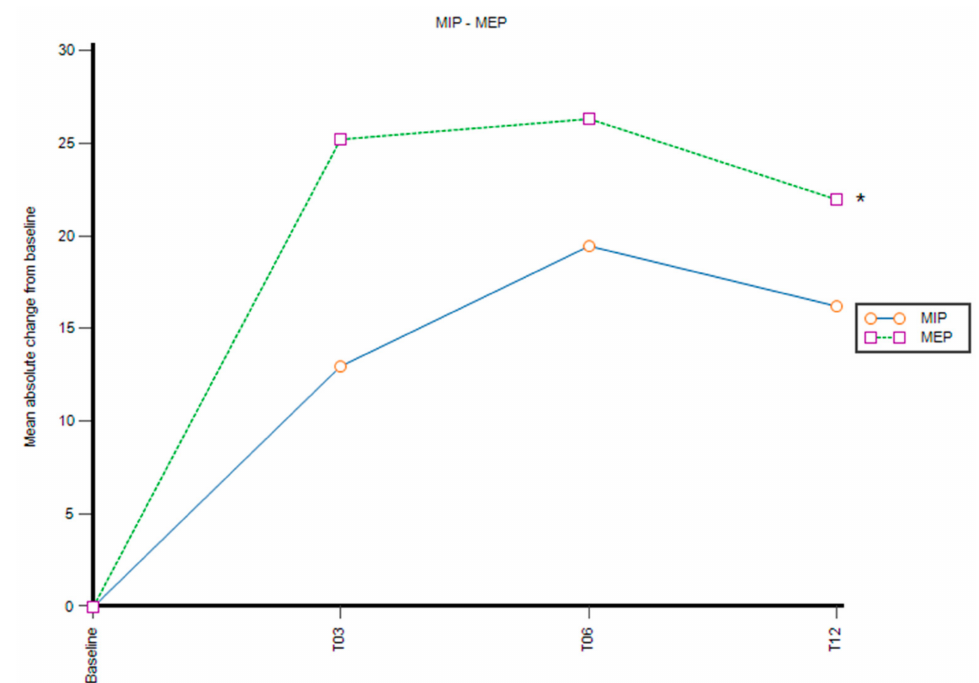
Figure 2. Mean of the absolute change from baseline in MIP and MEP. T03: 3 months, T06: 6 months T12: 12 months. *: p <